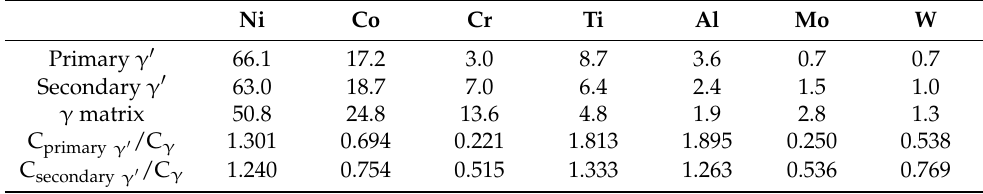
Table 1. Alloy element distribution (wt %).